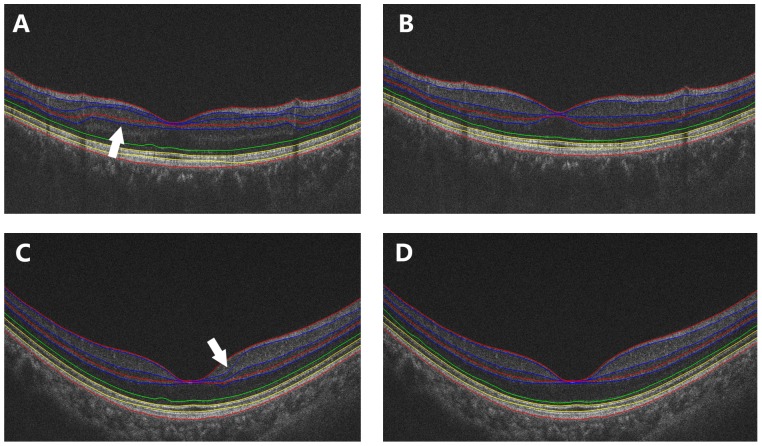
Segmentation errors in scans of lower image quality and corresponding corrected segmentation after applying the semi-automated approach.(A) The algorithm mistakenly identified the OPL/ONL interface. (B) Corrected segmentation corresponding (A) after applying the semi-automated approach. (C) The algorithm mistakenly identified the RNFL/GCL boundary. (D) Corrected segmentation corresponding (C) after applying the semi-automated approach.